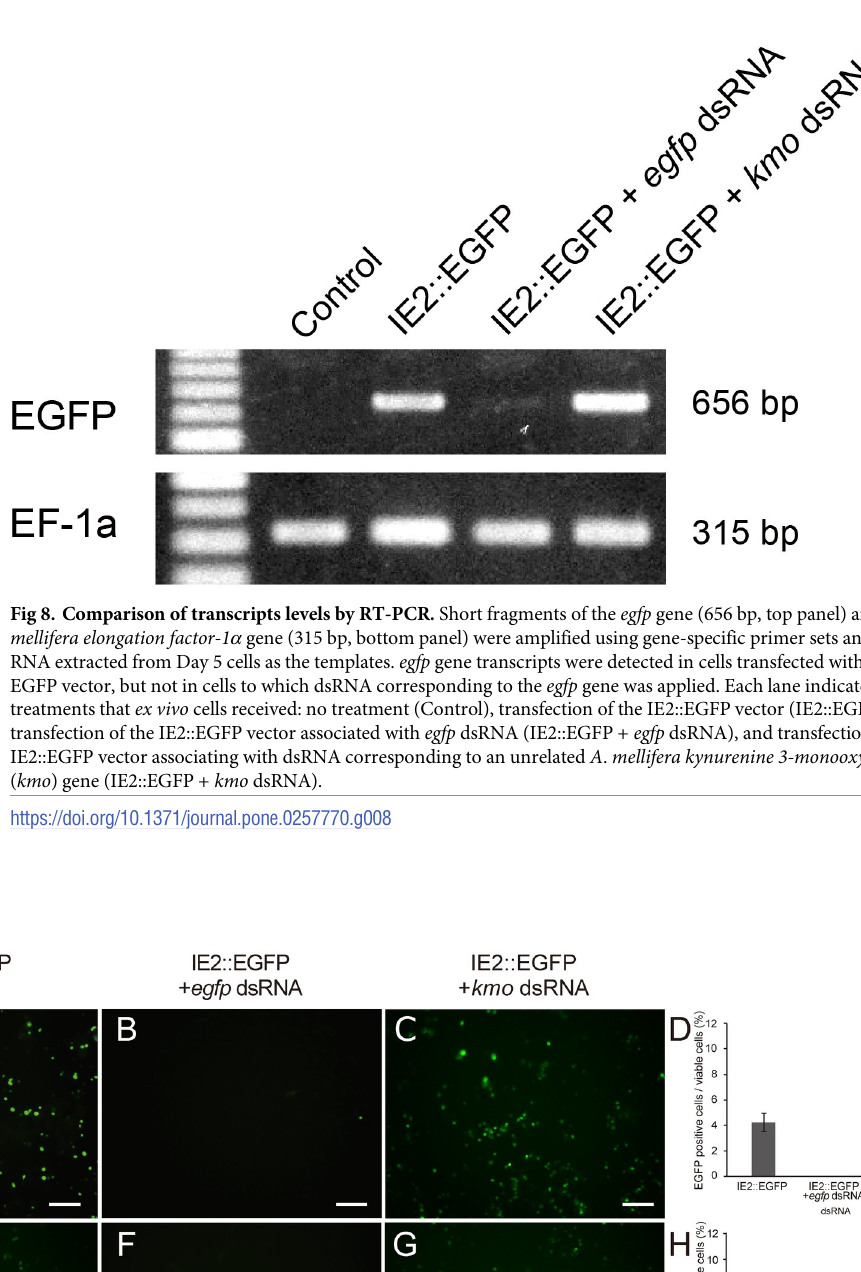
PLOS ONE | https://doi.org/10.1371/journal.pone.0257770 September 23,